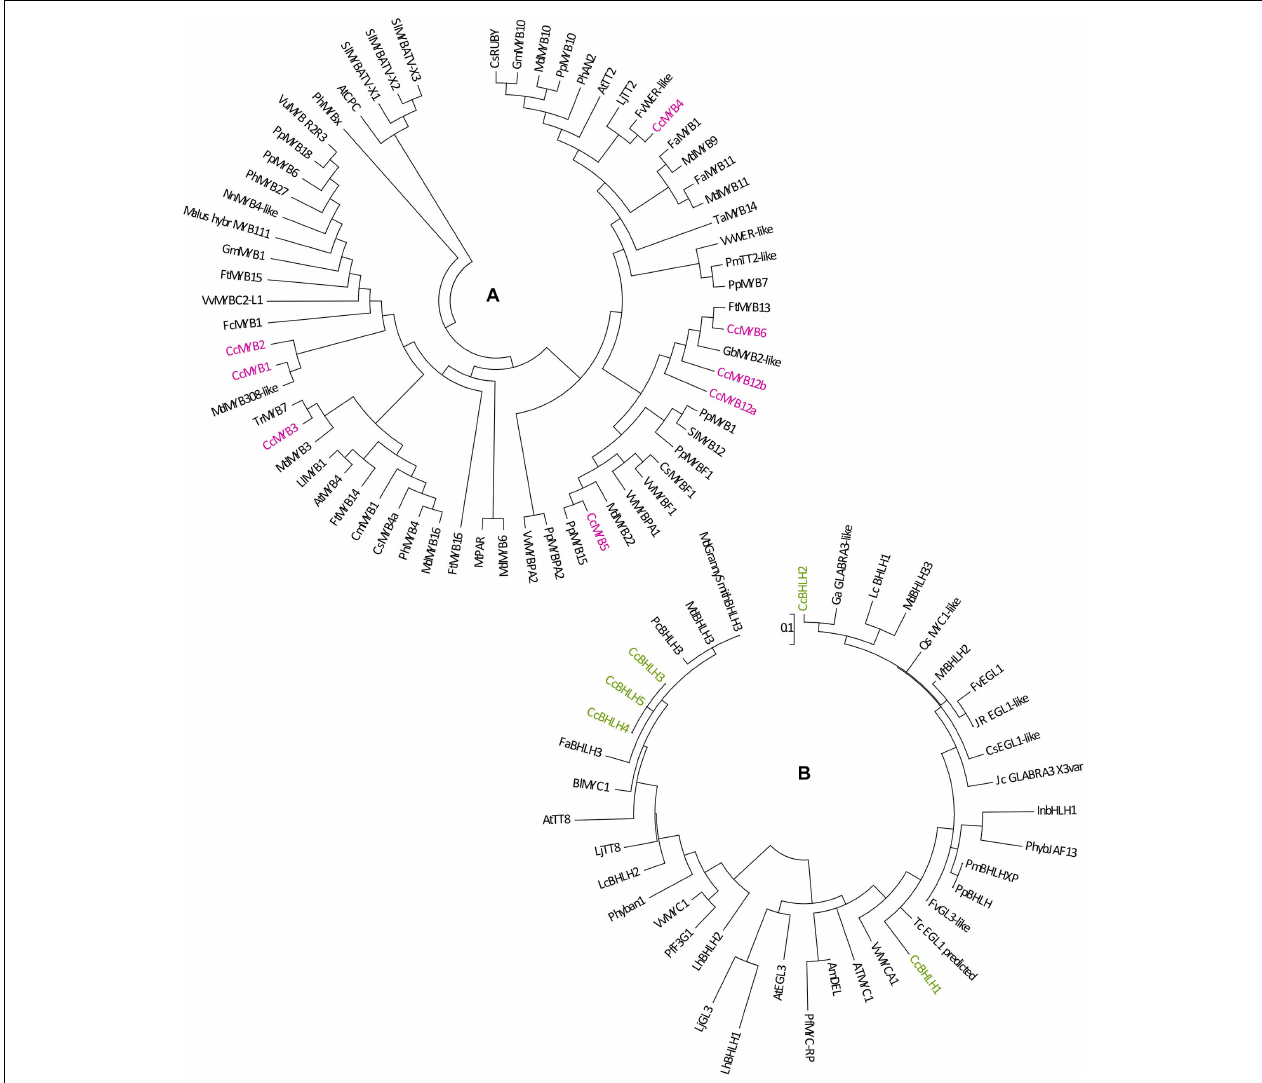
FIGURE 3 | Phylogenetic trees derived from MYB and BHLH transcription factors involved in the regulation of flavonoid pathway. Phylogenetic analysis of putative MYB amino acid (A) and BHLH nucleotide sequences (B) from Cistus and a range of other species. Sequences were aligned using Clustal W, and a maximum likelihood tree was formed from the alignment. The scale bars represent 0.2 (A) and 0.1 (B) substitutions per site. The GenBank accession numbers are as follows: AtCPC (AAN78321.1), AtMYB4 (AT4G38620), AtTT2 (AJ299452), Ccl MYB41like (XP_024033719.1), CmMYB1 AEO27497.1, CpMYB41-like